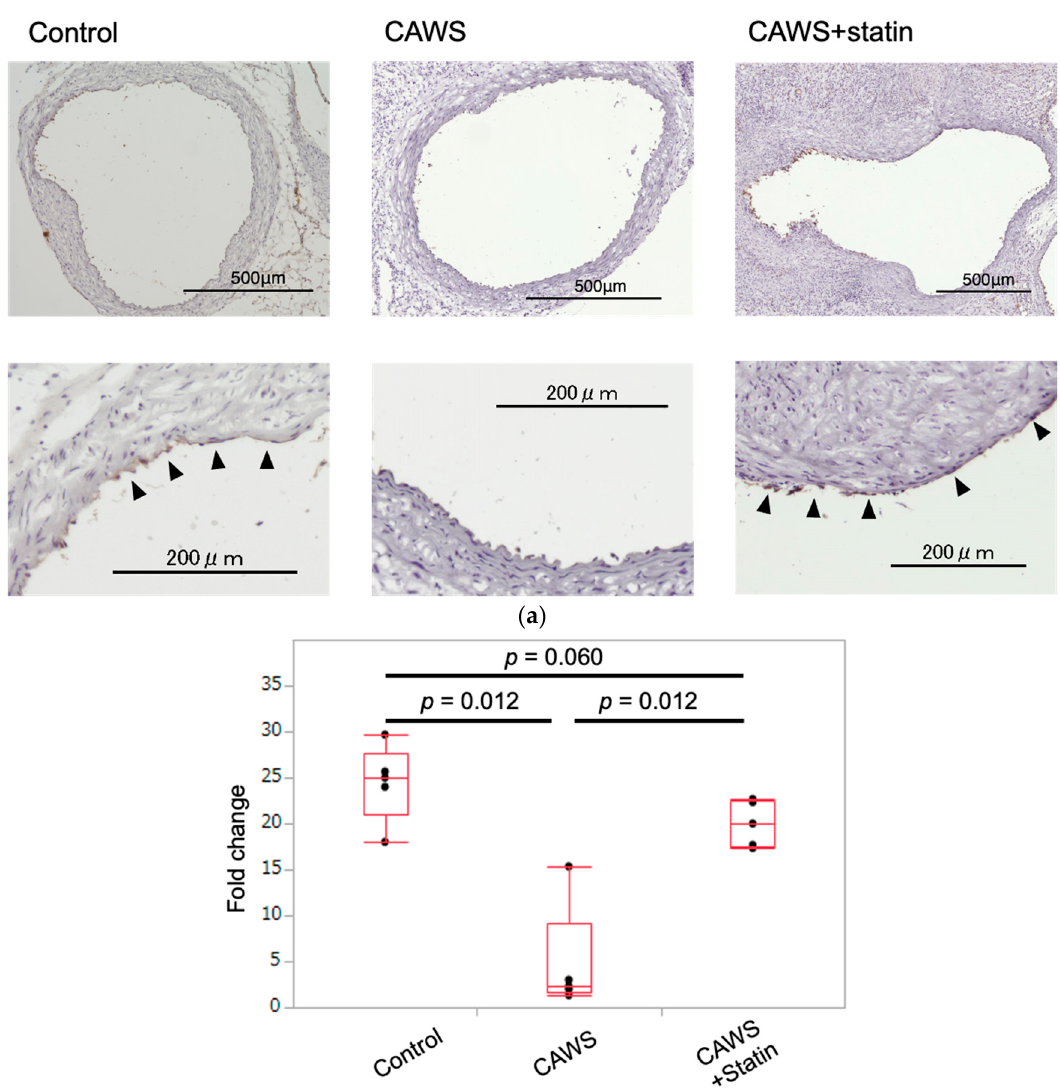
Figure 1. Endothelial nitric oxide synthase (eNOS) staining and scoring of the strength of eNOS expression in ascending aorta. ( a ) Frozen transverse sections of the ascending aorta were immuno- stained to detect eNOS. Near-continuous eNOS expression (black arrowheads) was observed in the control group but was suppressed in the CAWS group. Partial eNOS expression was observed in the CAWS+statin group (upper bar = 500 μ m; lower bar = 200 μ m). ( b ) The aorta was divided into 12 sections and the degree of eNOS expression in each region scored on a 36-point scale from 0 to 3. eNOS expression was significantly suppressed in the CAWS group compared with the control group and was upregulated in the CAWS+statin group compared with the CAWS group.